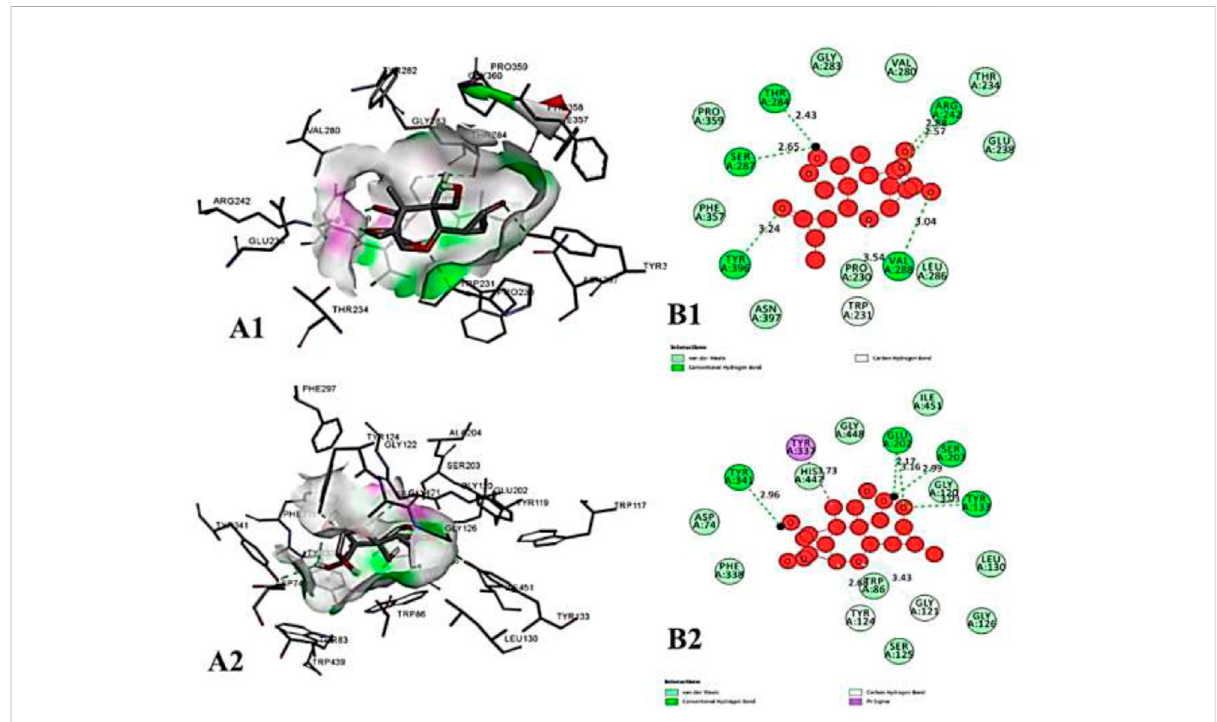
FIGURE 12 The molecular docking interactions of ligand nivalenol with (A) 4AQD and (B) 4EY7 receptors in 2D and 3D representation.